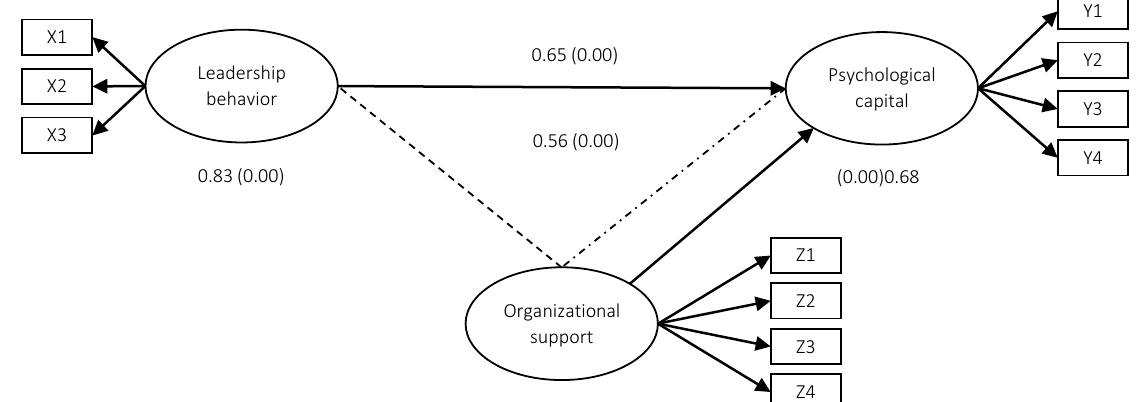
Figure 1. The role of organizational support in the relationship between leadership behavior and psychological Table 11. Results of the path analysis to measure the impact of leadership behavior on psychological capital in the presence of organizational support as an intermediate variable Beta value Beta value Track T-value